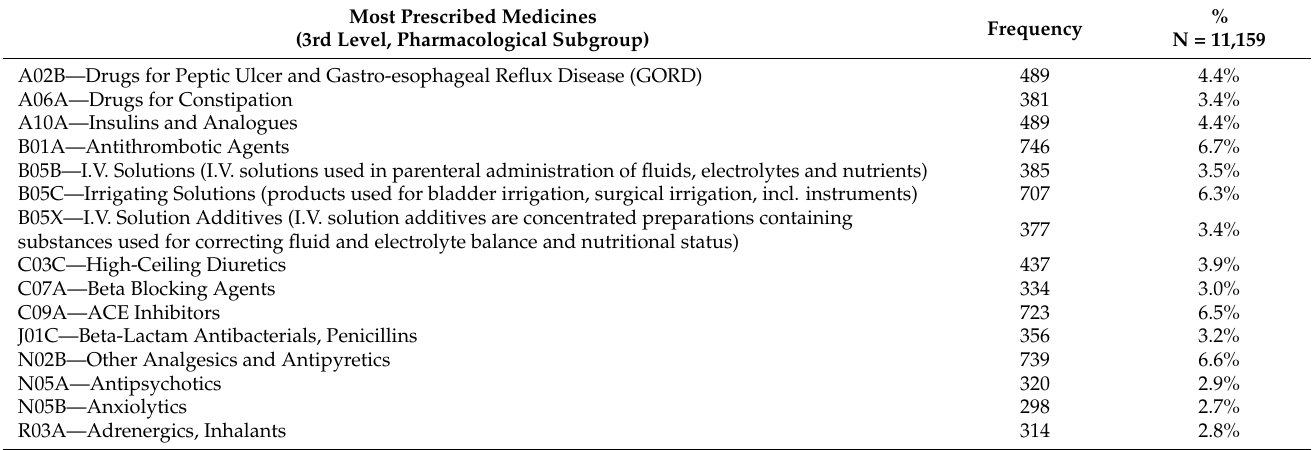
Table 2. Most prescribed medicines, third level, pharmacological subgroup.